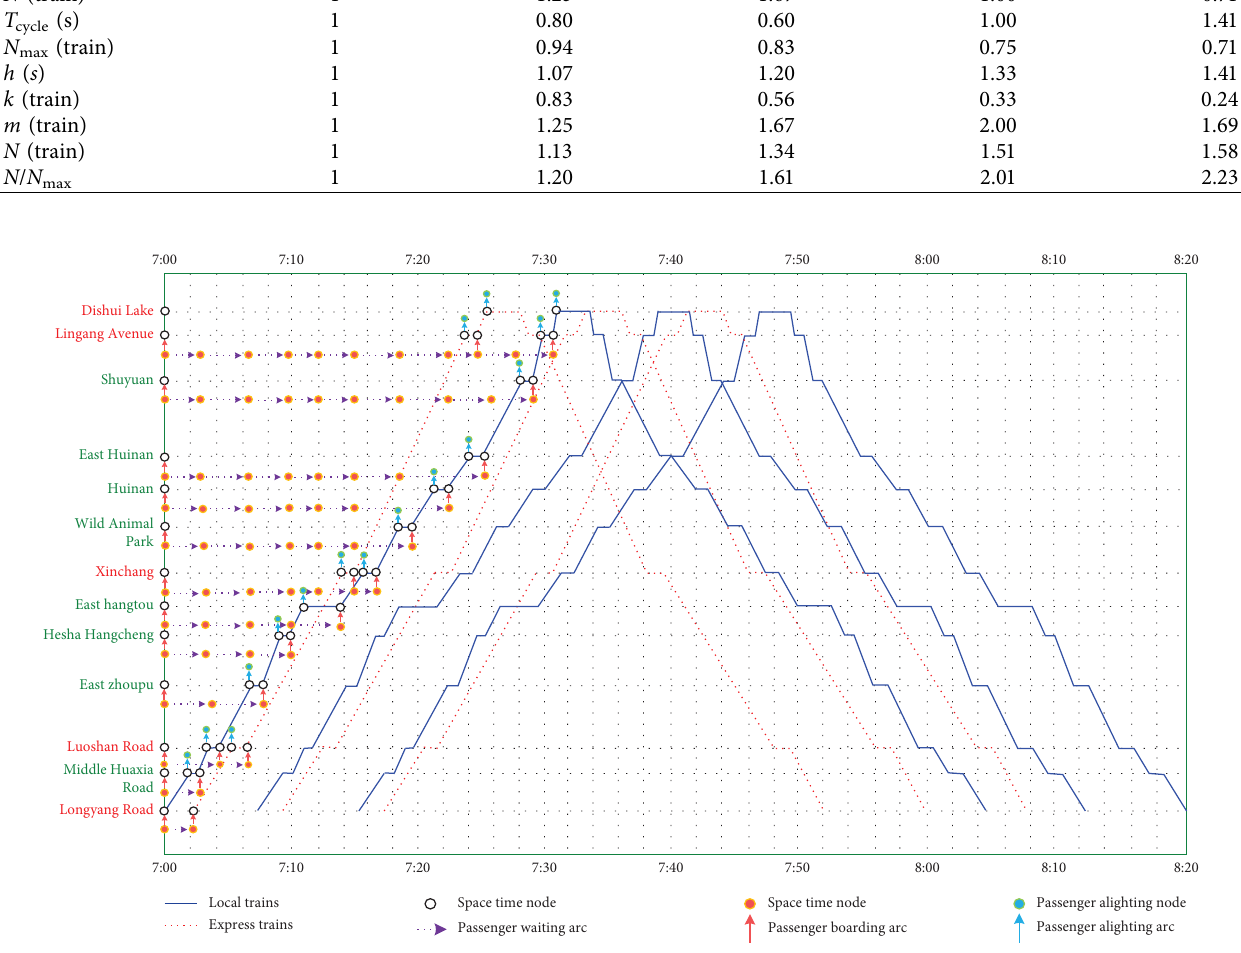
Figure 9: Optimization proposal of Shanghai rail transit line 16 train operation (part). Note: In Table 5, the red stations are the express stations, the green stations are the stations with crossing conditions, and the rest are ordinary